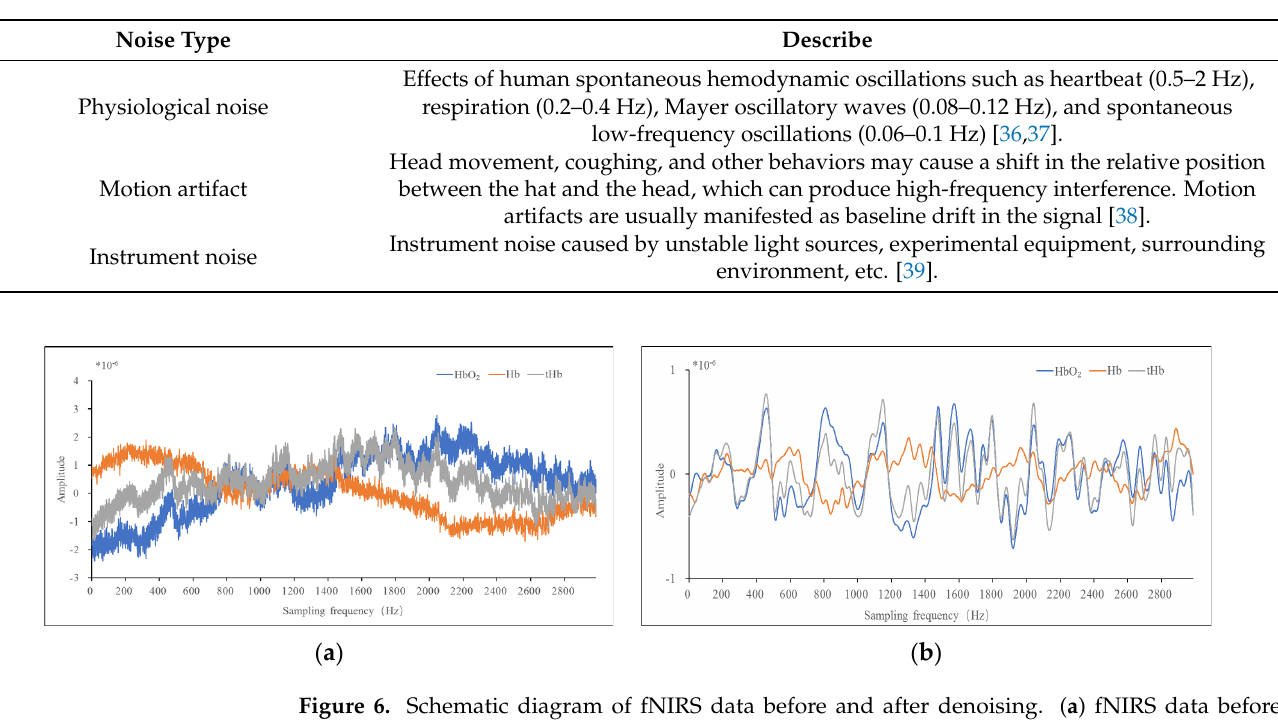
Table 3. Main noise in fNIRS signal.